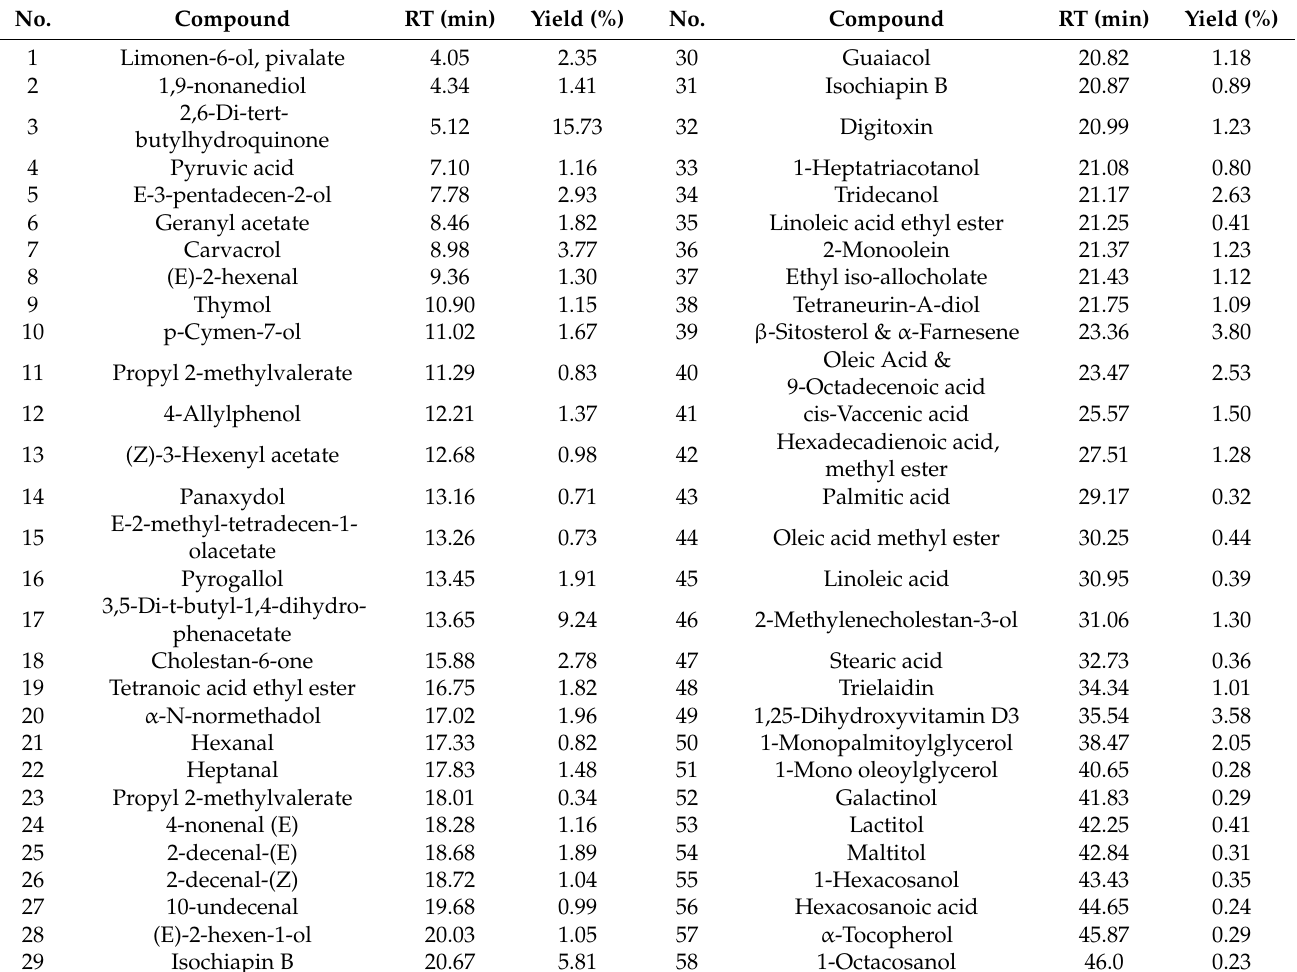
Table 1. Chemical composition of